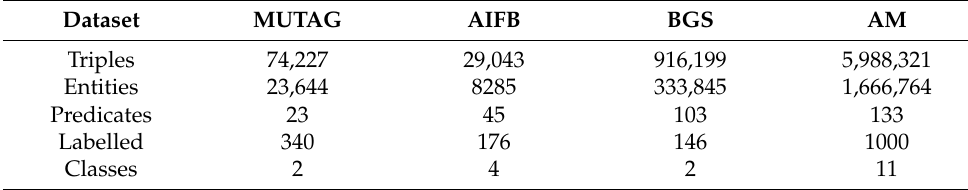
Table 1. Summary of datasets used in this